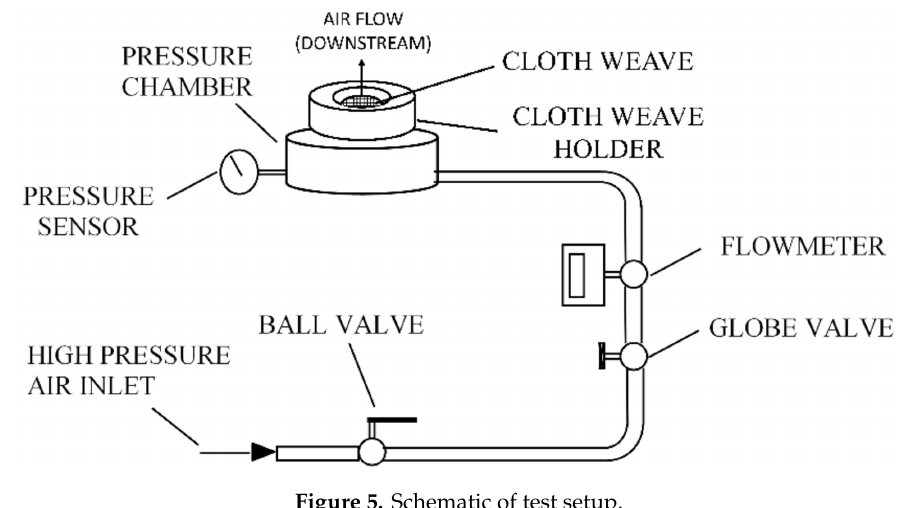
Figure 5. Schematic of test